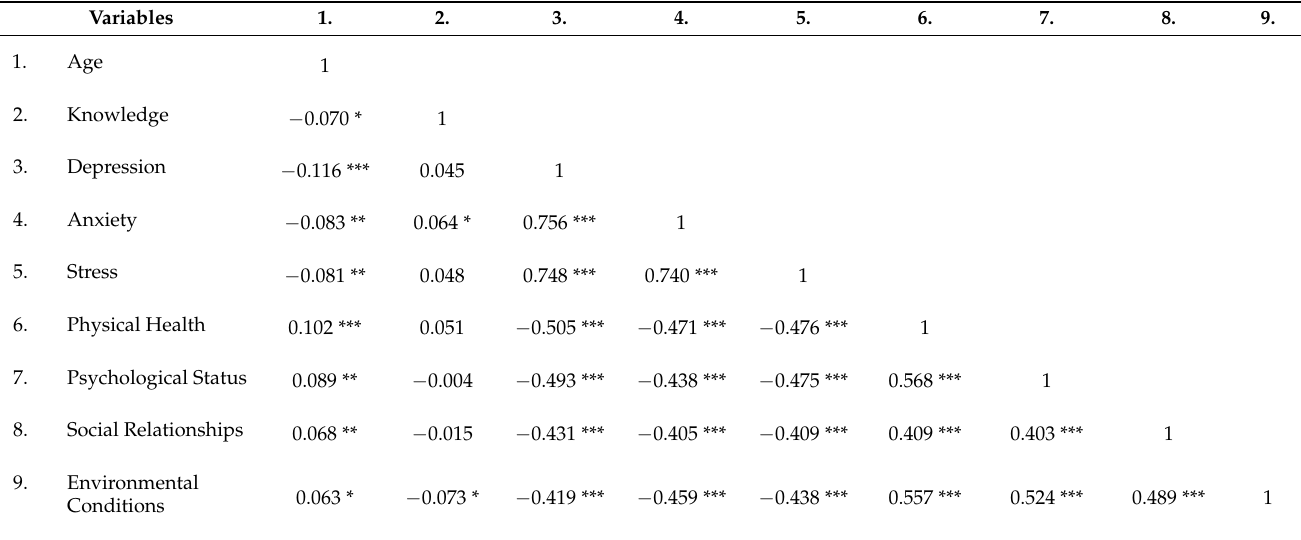
Table 4. Pearson Correlation Coefficient Matrix of the Measured